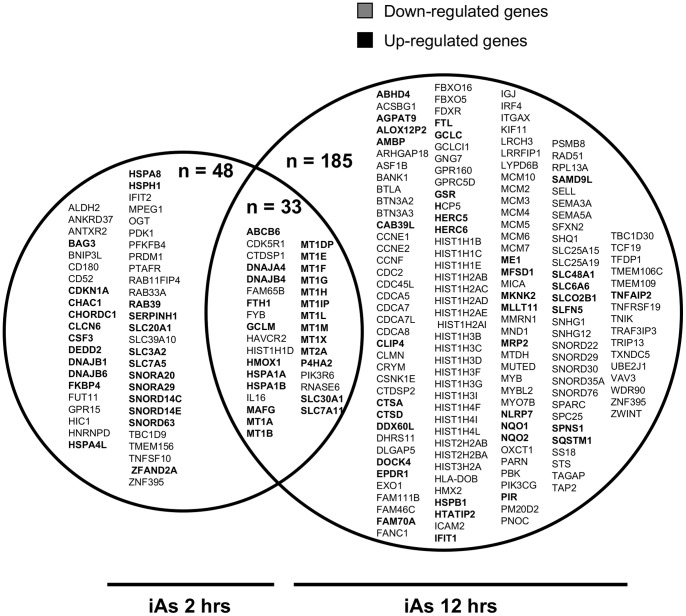
Comparison of altered genes at different times after iAs exposure.Venn diagram depicting genes affected exclusively at 2(left circle), 12 hrs of exposure to 5 µM of iAs (right circle) and both.